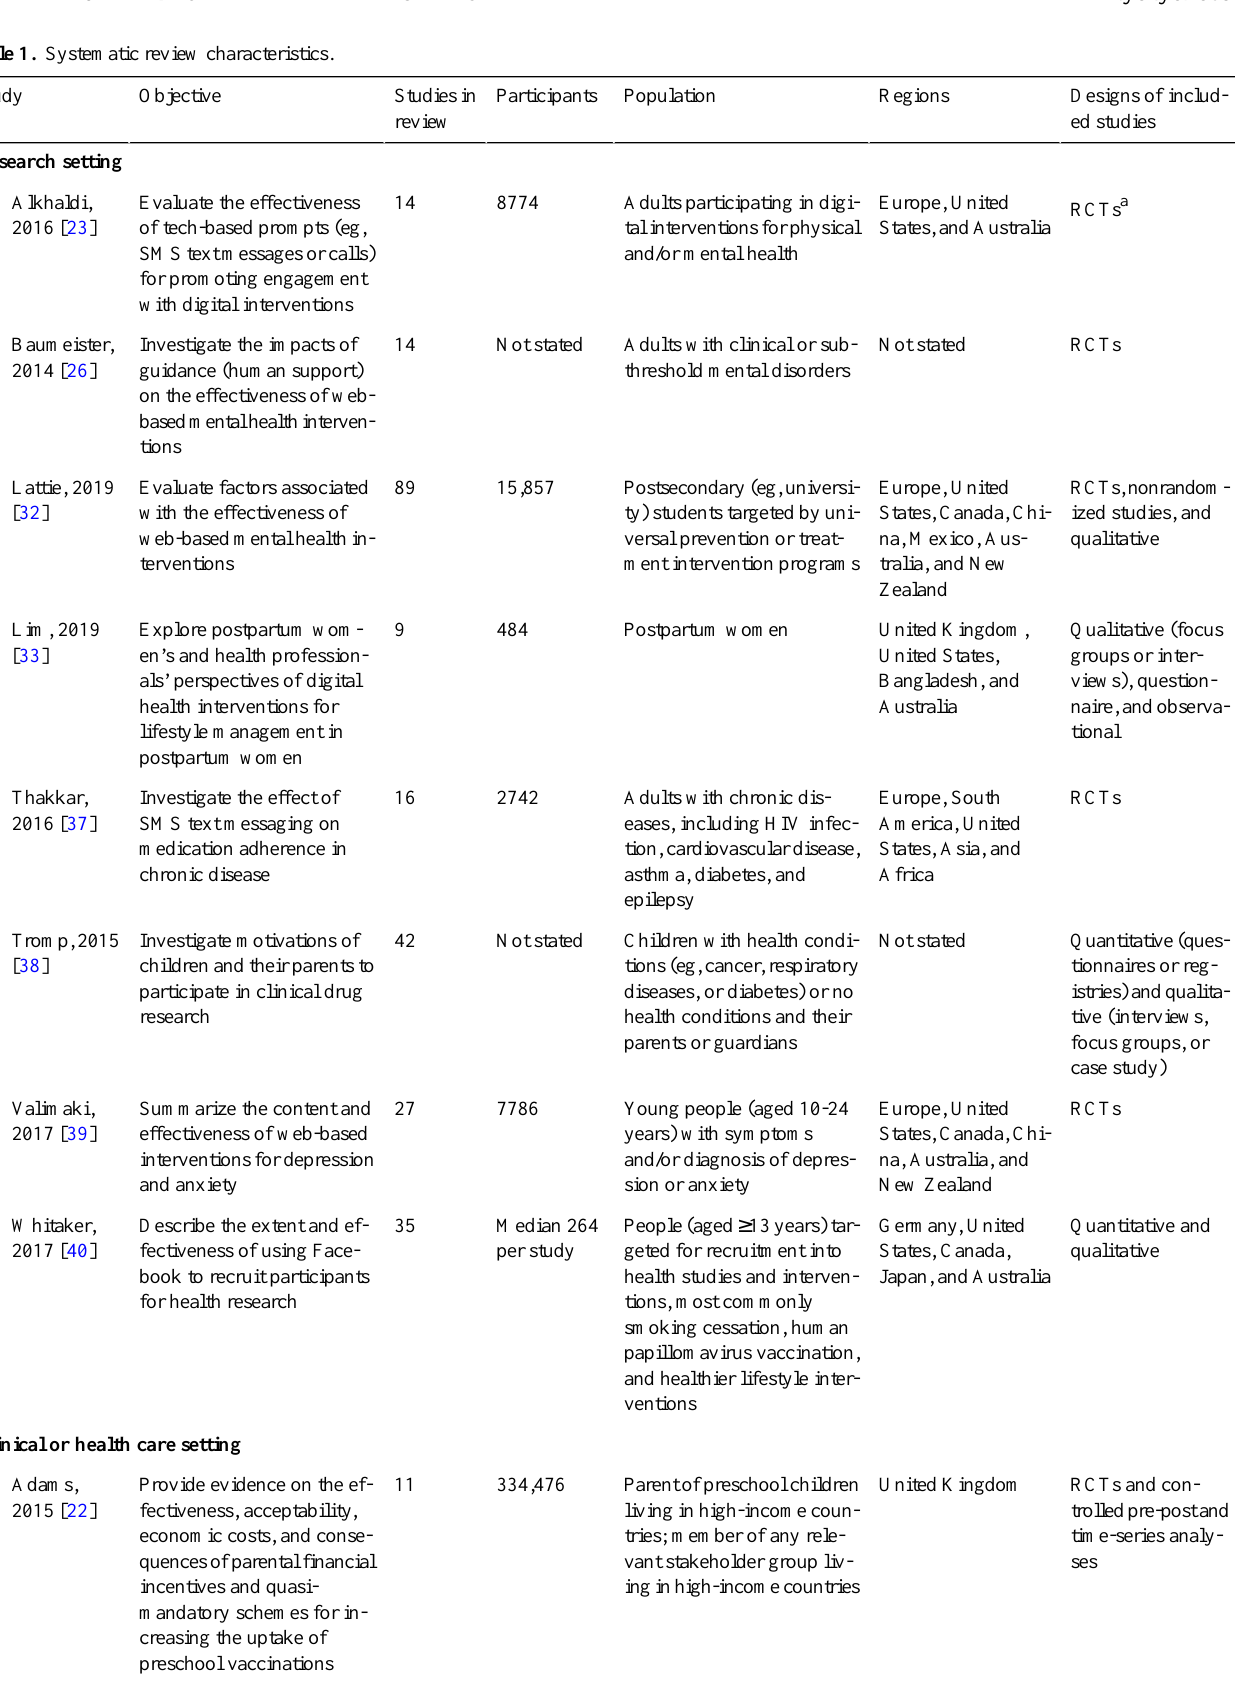
Table 1. Systematic review characteristics.